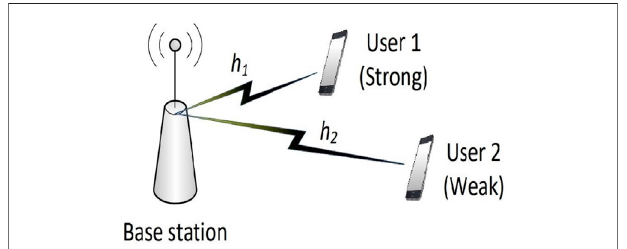
FIGURE 1 | A NOMA system with